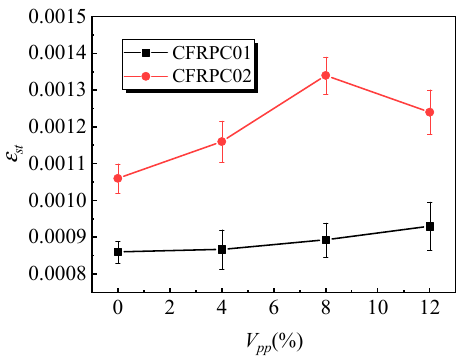
Figure 10. Effect of the polymer–cement ratio on the peak strain of the specimens in the splitting tensile test.